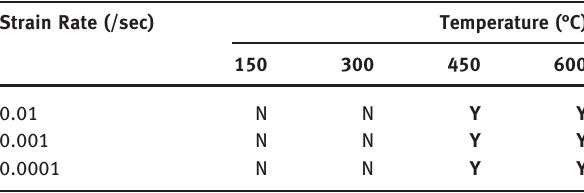
Table 3: Constants obtained for KHL model constitutive model. A